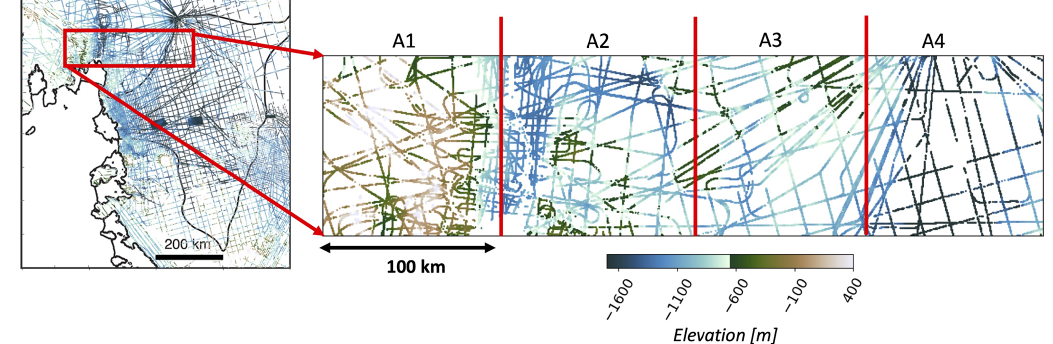
Figure 6. A subset of the pine island glacier is used to illustrate the methodology. The red line divided four subareas: A 1 , A 2 , A 3 , and A 4 . The black coloured areas highlight line gaps of the selected subset.